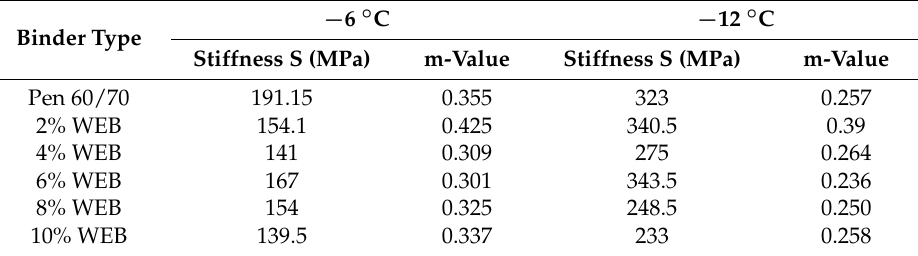
Table 4. Bending beam rheometer (BBR) test results.